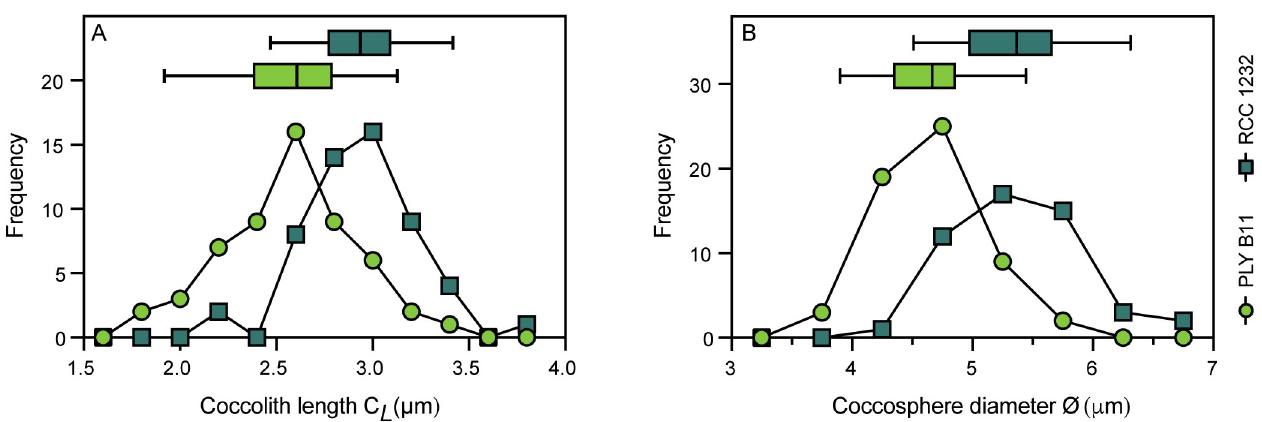
Fig 3. Coccolith and coccosphere morphology of strain PLYB11 (green, circle) and strain RCC1232 (blue, square) grown at control salinity 35. (A) Coccolith length (0.25 μ m bin size) and (B) coccosphere diameter (0.5 μ m bin size). Descriptive statistics (median, 10 th , 25 th , 75 th , 90 th percentiles) of the data for each strain are presented above each histogram as box-and-whisker plots.